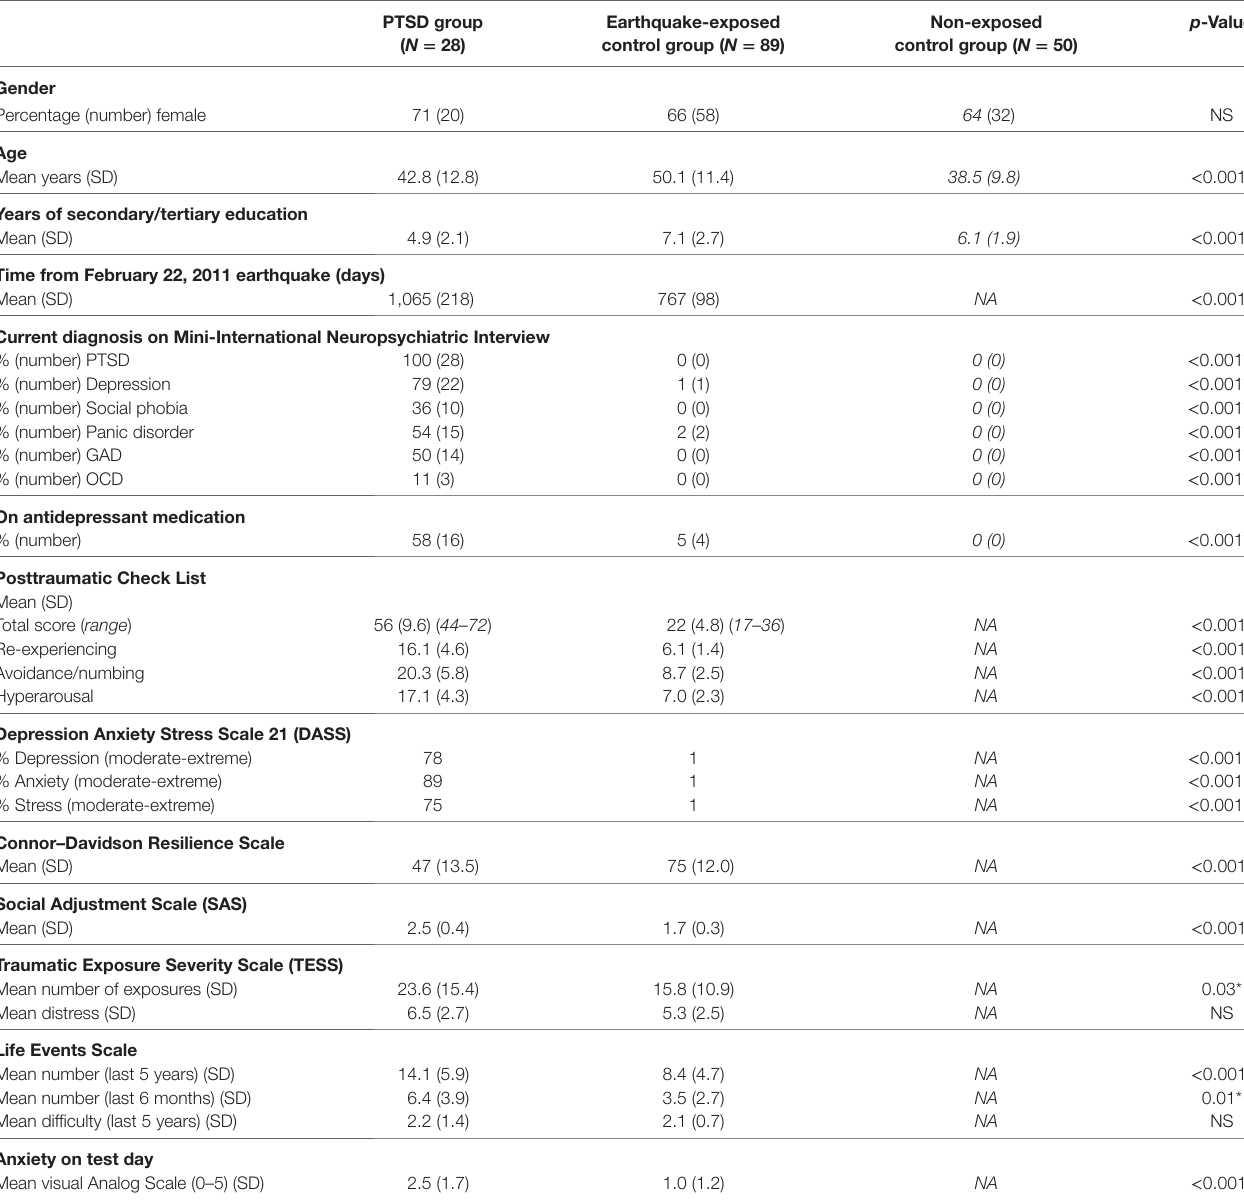
TaBle 1 | Comparison of demographic and clinical variables between posttraumatic stress disorder (PTSD) group, earthquake-exposed controls, and non-exposed controls (in italics).